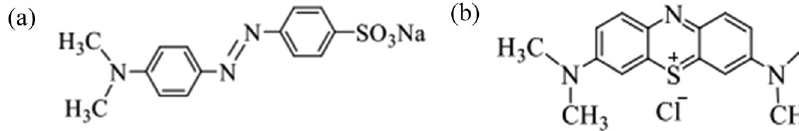
Figure 1: Chemical structures of ( a ) MO and ( b ) MB.